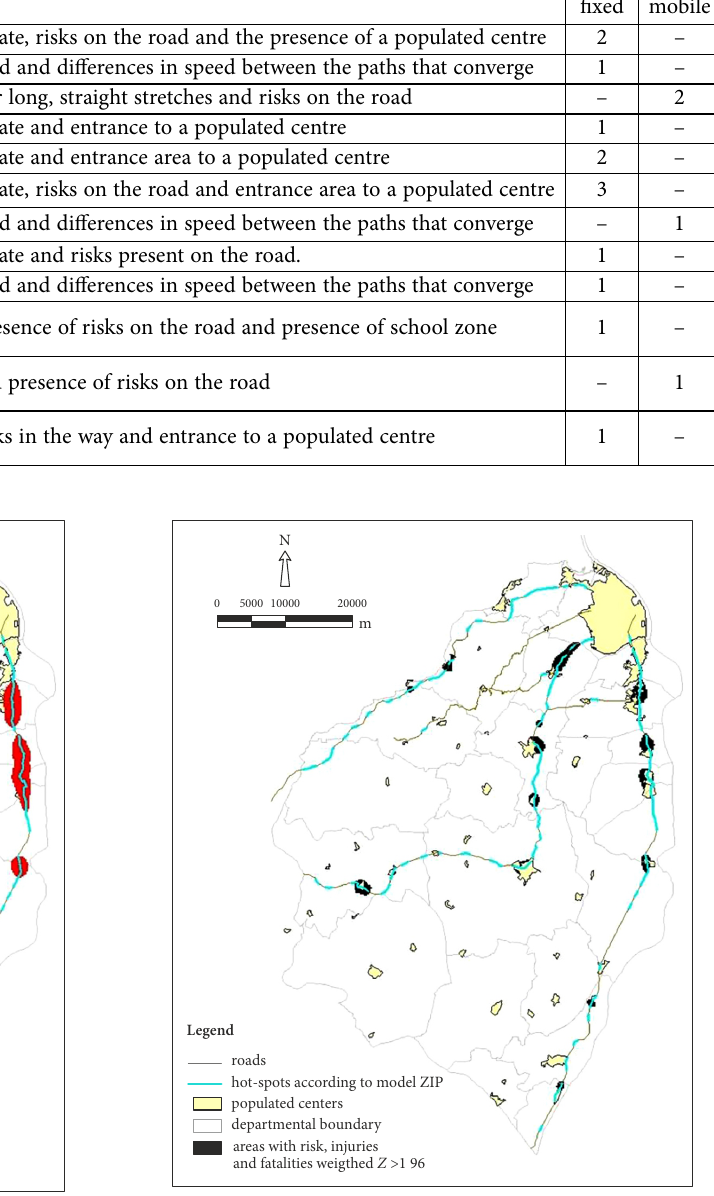
Figure 15. Hot-spots overlapping considering ZIP model and FWI with accident